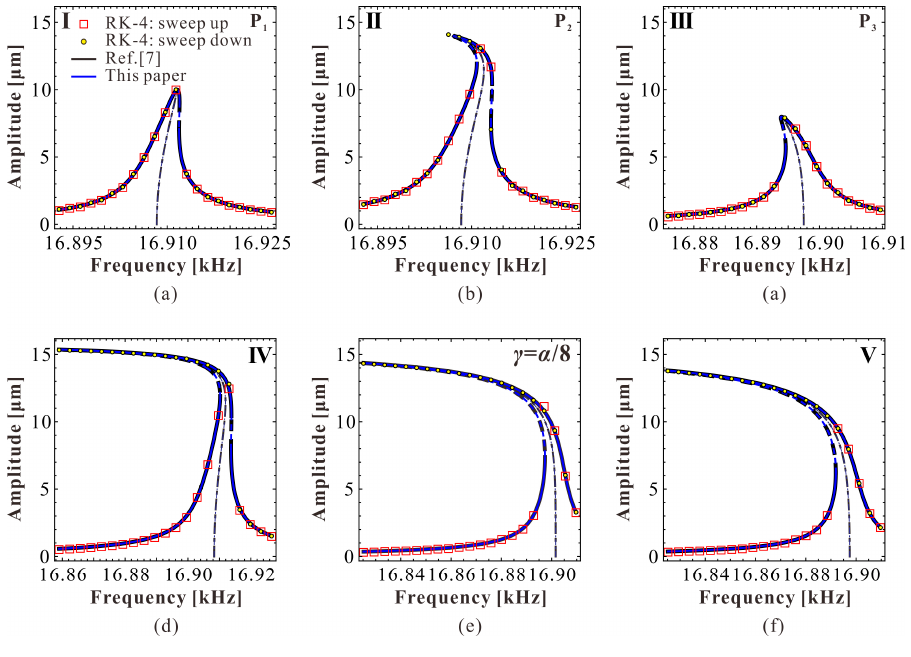
Figure 11. A dimensional zoning diagram depicting the extreme amplitude versus DC voltage. ( a ) Global view; ( b ) local view.